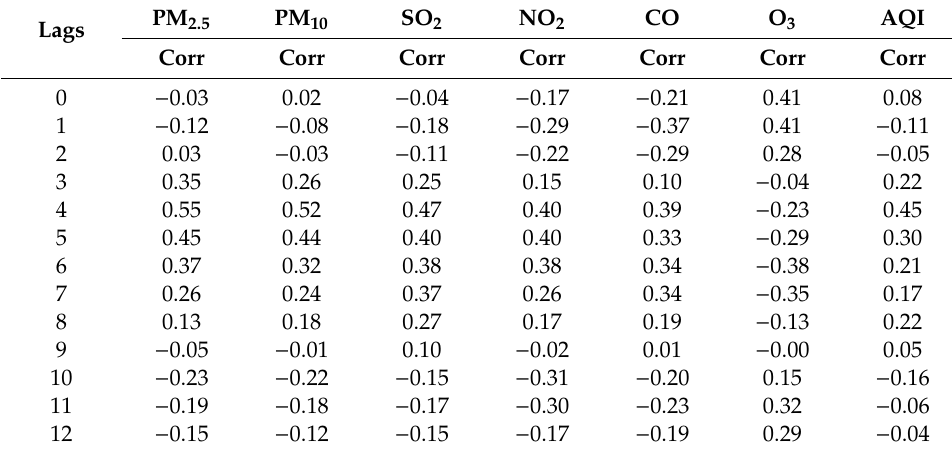
Table 1. Cross-correlation coe ffi cients between concentrations of PM 2.5 , PM 10 , SO 2 , NO 2 , CO, O 3 , and air quality index (AQI) at a single month over a range of time lags (0–12 months) and seasonality of